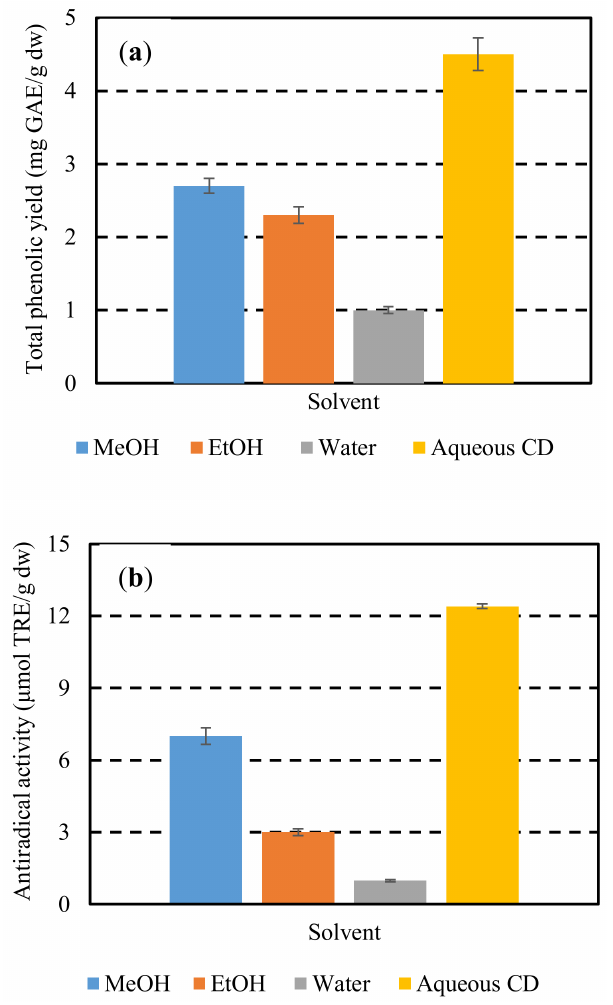
Figure 2. Total phenolic yields ( YTP ) ( a ) and antiradical activities ( AAR ) ( b ) obtained by extraction with methanol, ethanol, water, and aqueous solutions of CD at optimum